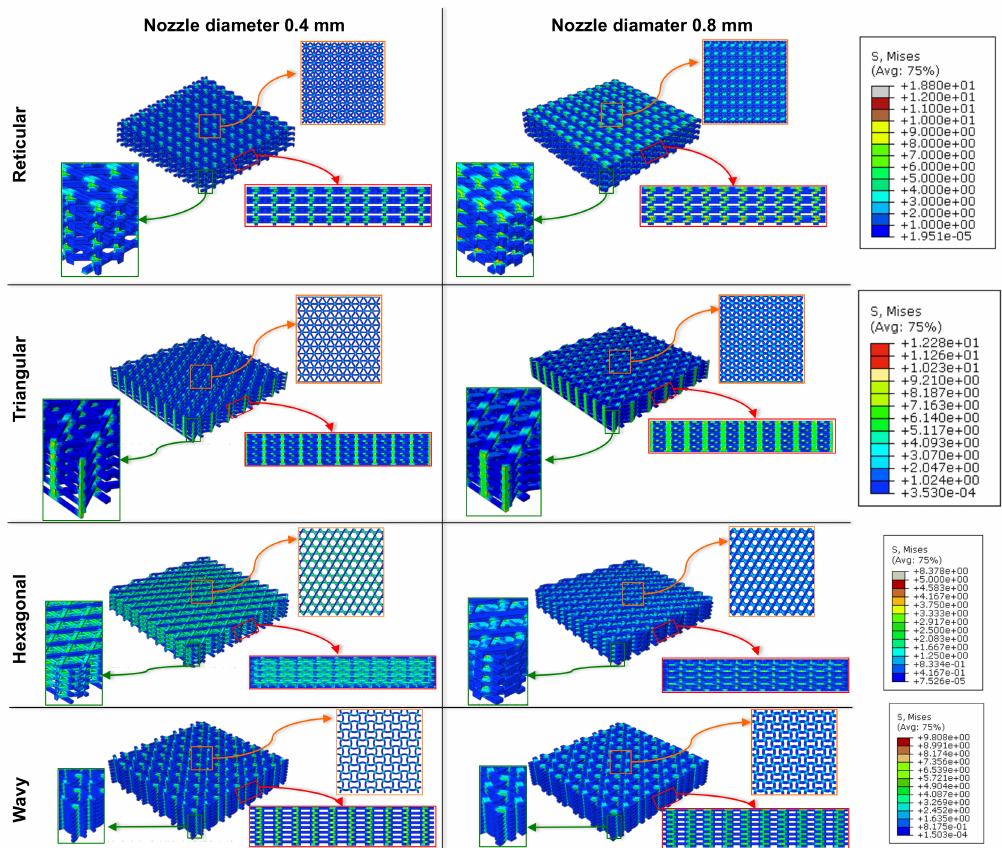
Figure 3. FEM models under compression. Von Mises stress distribution of lattice scaffolds with different geometries and nozzle diameters. The stress value increases from blue to red colors. In orange, the top view magnification of stressed scaffold; in red and green, the magnification of load